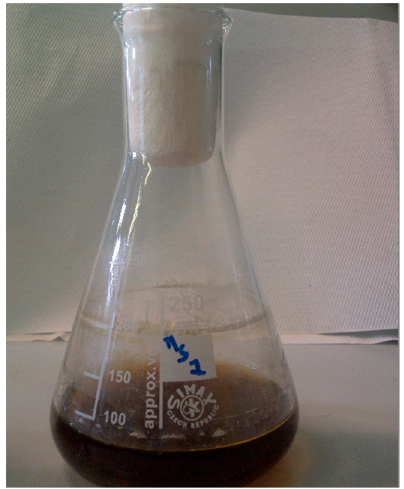
Figure 1. Melanin pigment of Sc-Ms1 in Modified Phenoxazinone Production Medium (MPPM) culture broth.